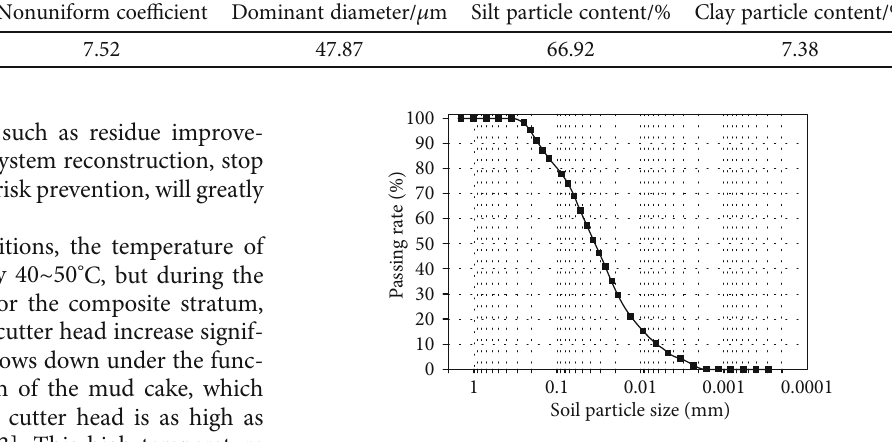
Figure 1: Grain size distribution curve of used clay soil